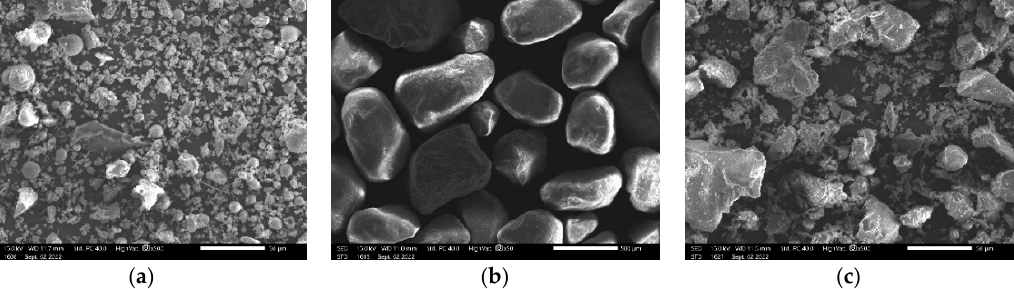
Figure 1. SEM micrographs of ( a ) fly ash, ( b ) quartz sand, ( c ) basalt flour.